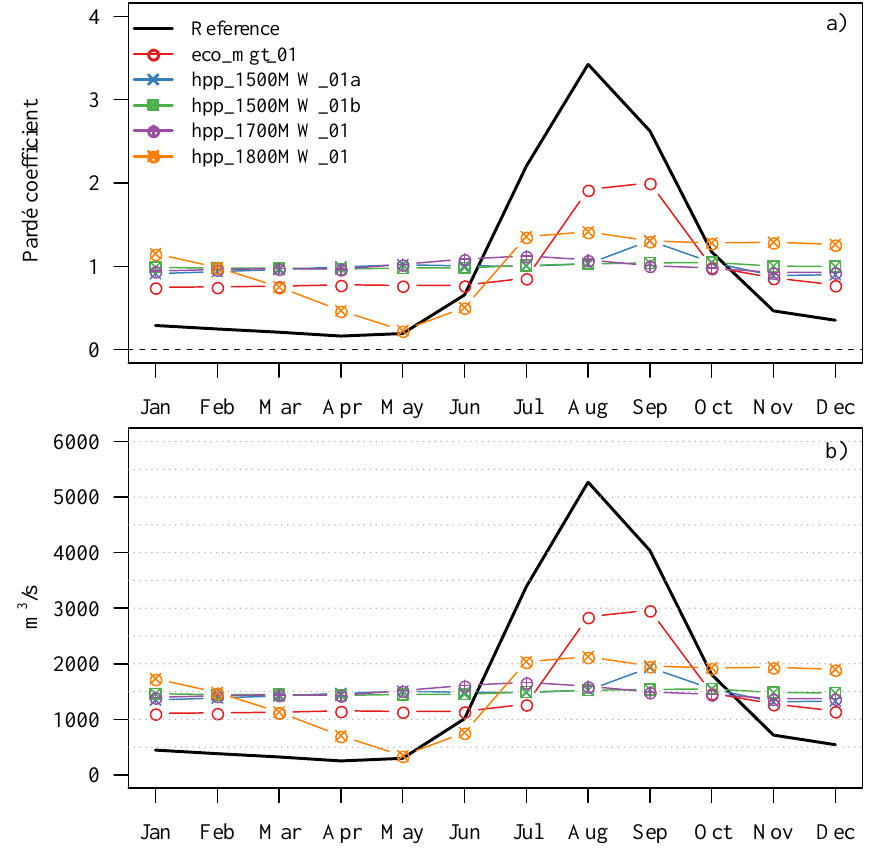
Figure 6. Pardé coefficients ( a ) and average monthly discharges ( b ) during